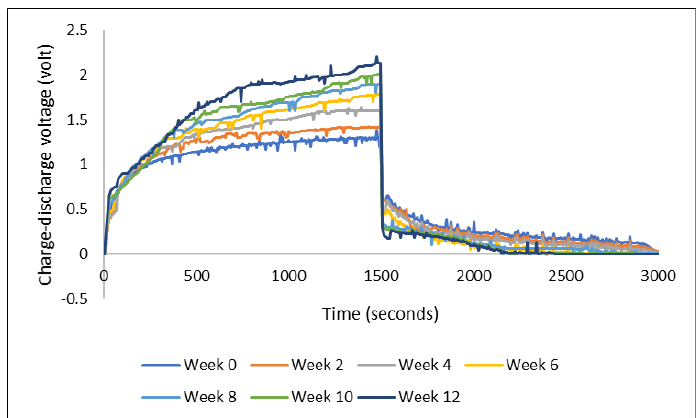
Figure 7. Charge-discharge profiles of a device along the storage in ambient condition.